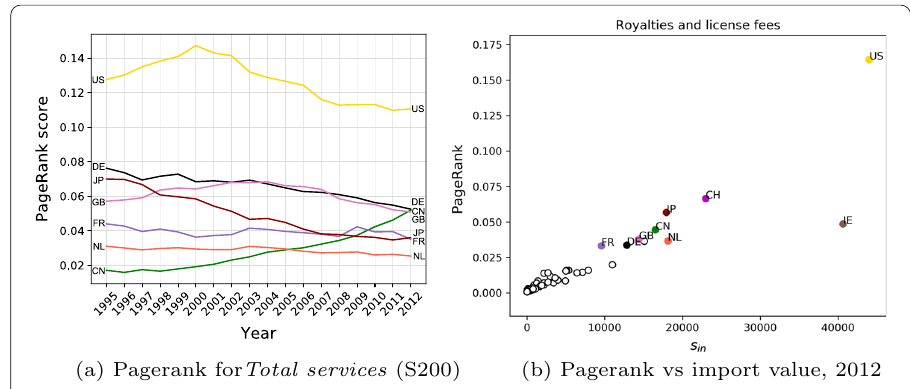
Fig. 6 Left: Pagerank time evolution for Total services (S200) (top ranking countries only). Right: Pagerank vs import value for Royalties and license fees (S266) in